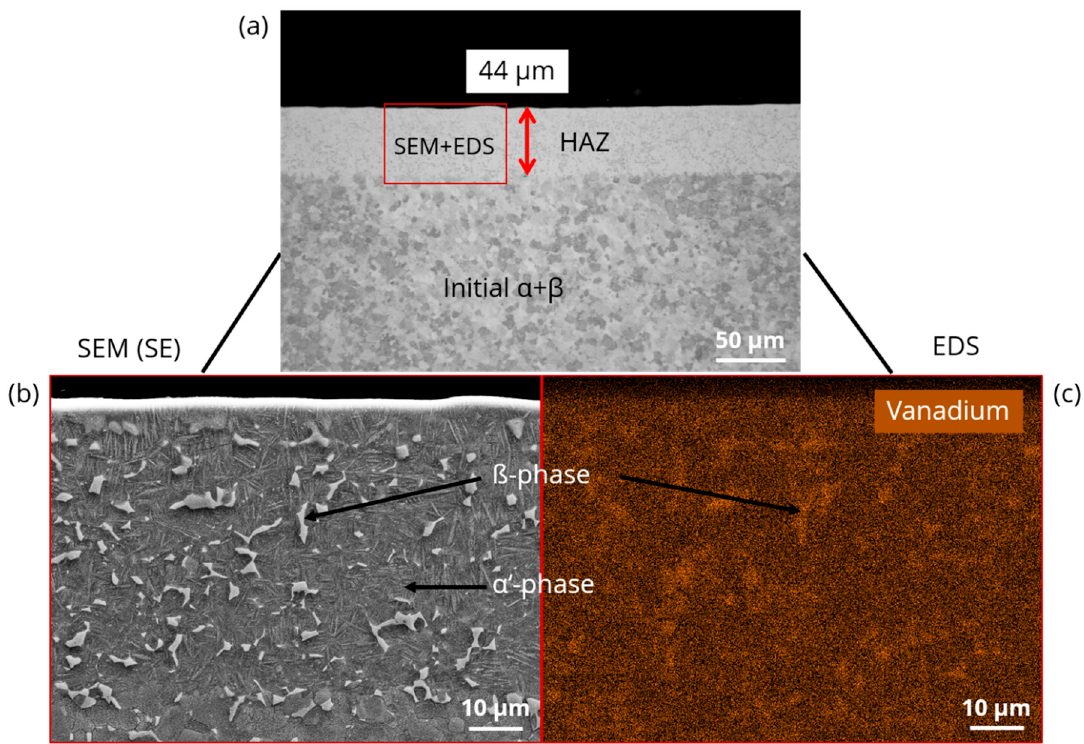
Figure 4. Typical HAZ at the upper cutting edge developed during the laser cutting process (Ti-6Al_LC sample): ( a ) Light microscopic image representing an overview; ( b ) SEM-image (SE cross-section) of the HAZ microstructure with α ’-martensite; ( c ) Element analysis (EDS) showing the higher vanadium content ( β -stabilizer) in the β -phase of the HAZ.